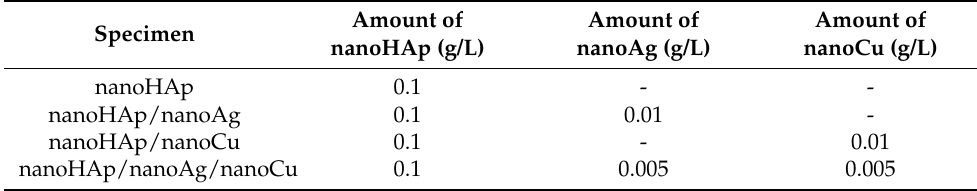
Table 2. Test variables, investigated components, and their